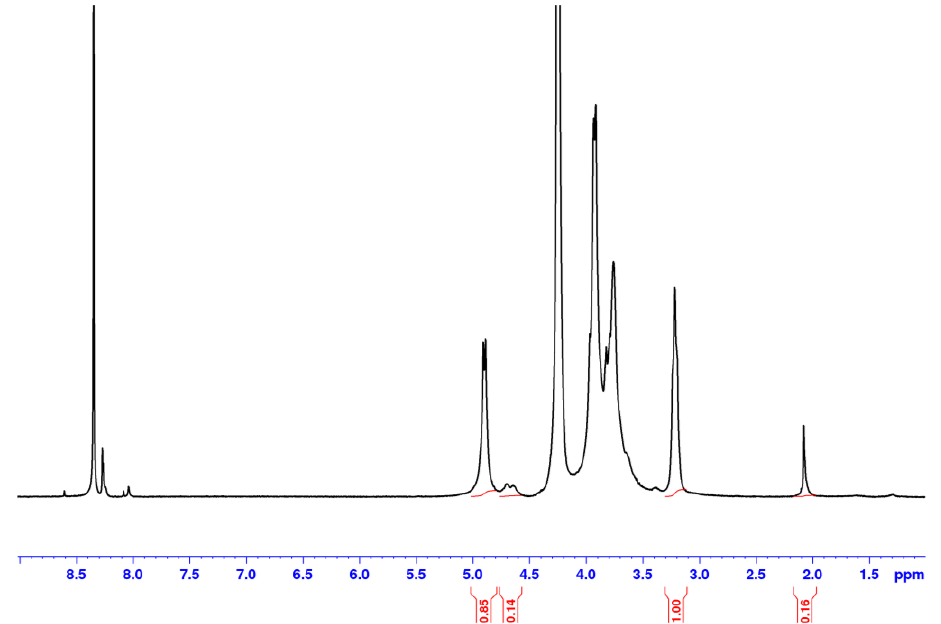
Figure 6. 1 H NMR spectrum obtained on a chitosan film casted from chitosan in D 2 O/DCl solvent at 85 °C.